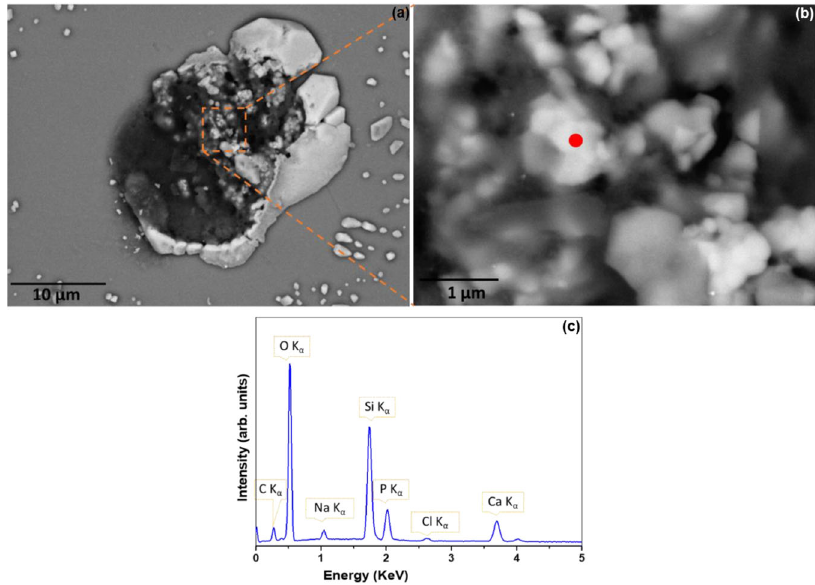
Fig. 7 SEM image (main image) along with corresponding elemental maps (Ca, P, Na, and Cl) from quartz substrate for single U-2 OS cell derived from TI-HA-AD after 28 days in culture under standard conditions. Scale bar represents 10 µm distance within main image